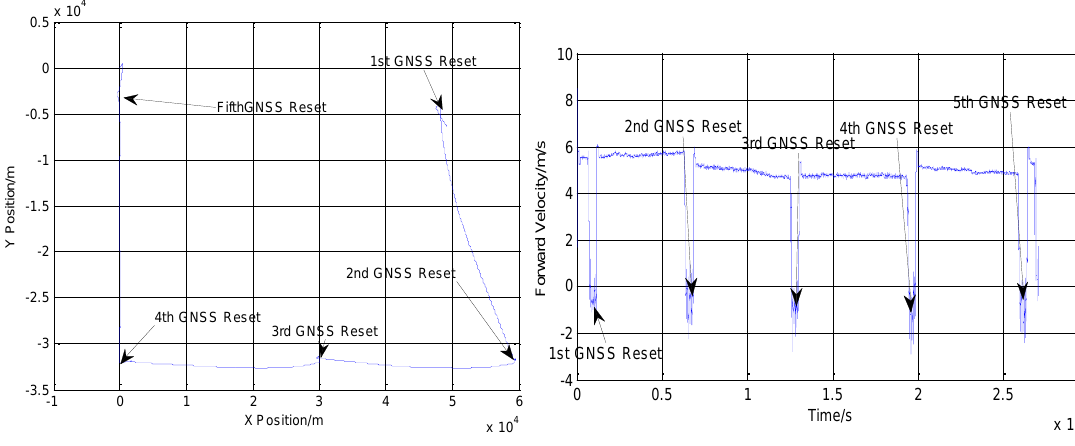
Figure 7. The trajectory and forward velocity of the AUV in Experiment 2.